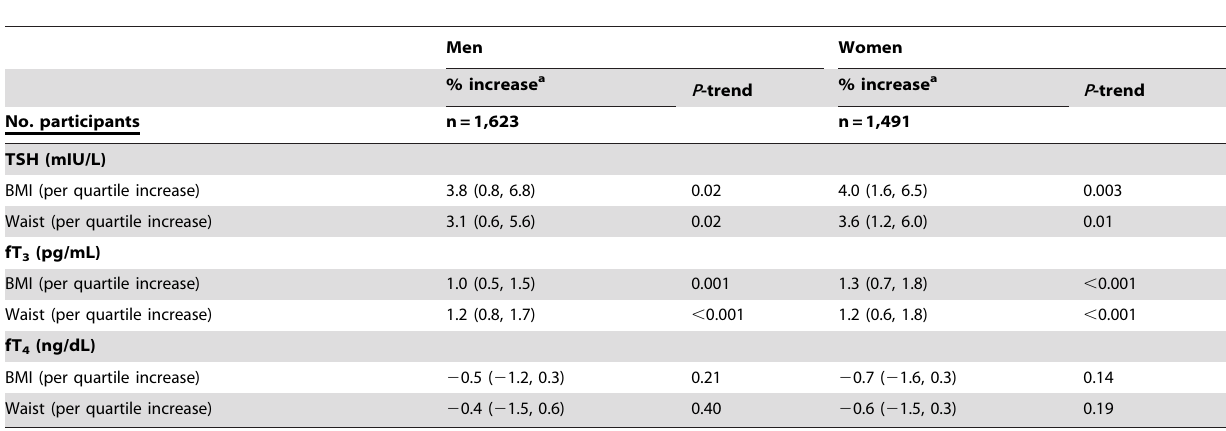
Table 2. Association of BMI and waist circumference with natural logarithm-transformed hormone concentrations, NHANES 2007–